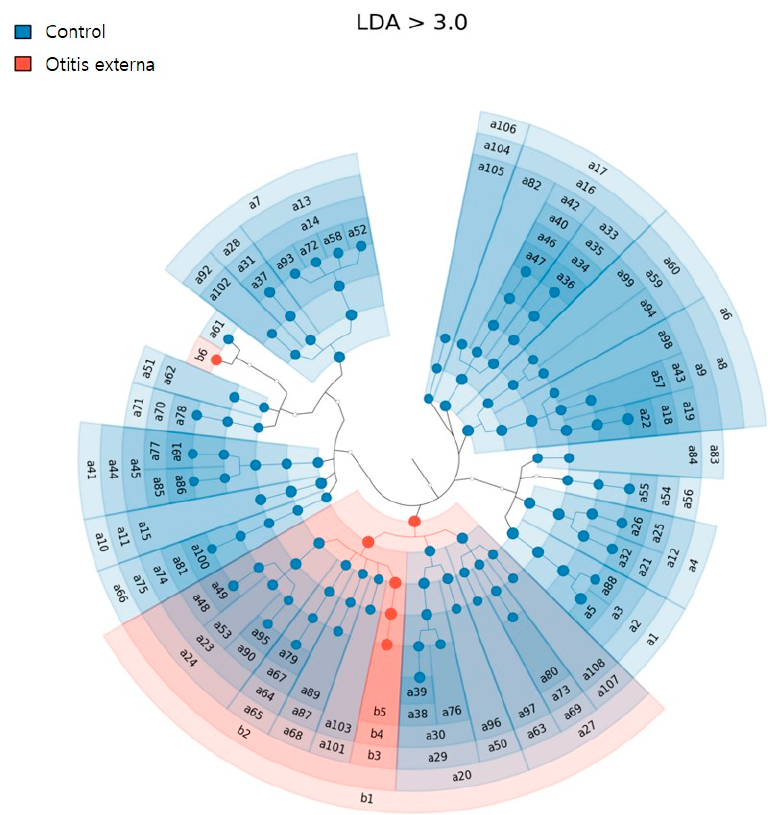
Figure 4. Results of Linear discriminant analysis effect size (LEfSe) analysis. Regions in red and blue indicate taxa significantly enriched in the otitis externa and control groups, respectively. Each ring represents a taxonomic level, with phylum in the outermost ring and species in the innermost ring. a: distinct taxa in control group, b: distinct taxa in otitis externa group. The number indicates an individual of taxa at each taxonomic level.